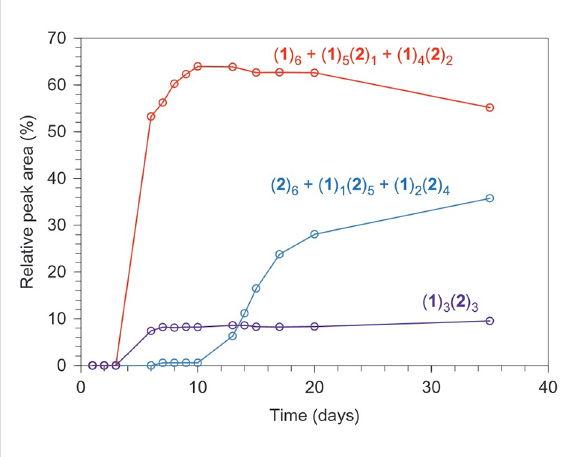
Figure 13: Plot showing the relative concentrations of set I (red), set II (blue) and the link between them; (1) 3 (2) 3 (purple). Note how at first only set I is present in the mixture, while at some point this set gives rise to the descendant set II. [52]